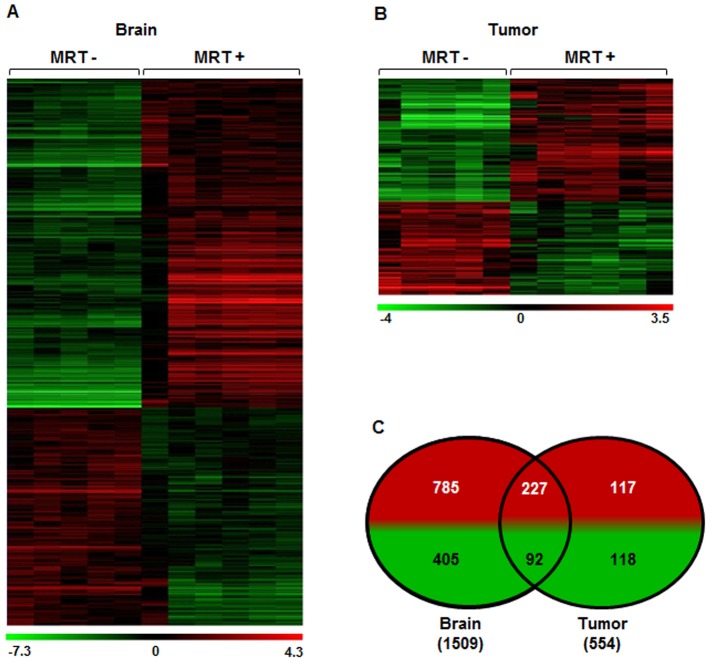
Influence of MRT on gene expression in tumor and contralateral brain tissues.a, b- Heat map showing either significant decrease or increase in mRNA expression after MRT in tumor and normal brain tissues. Colors indicate expression levels above (red) or below (green) the median value for each gene. Vertical columns indicate individual arrays and horizontal rows indicate genes. c- Venn diagrams showing the numbers of significantly increased (red) or decreased (green) genes after MRT in both tissues.